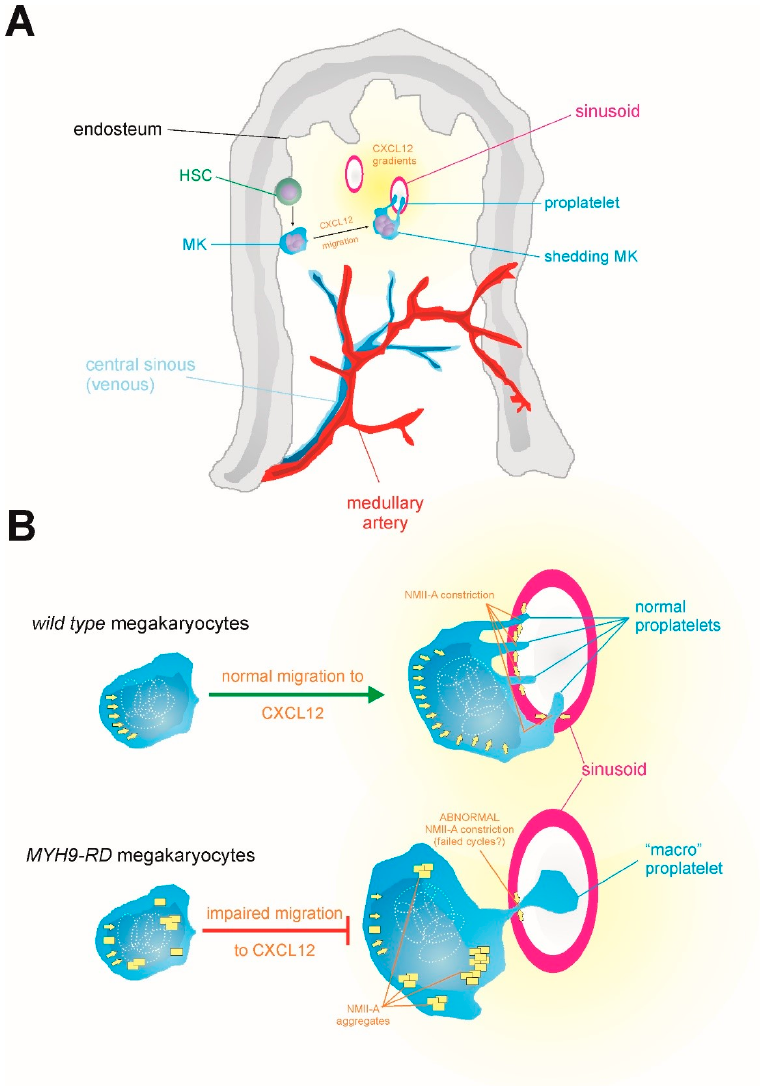
Figure 2. ( A ) Scheme depicting the generation and migration of megakaryocytes (MK) in the bone marrow. MK differentiate from HSC in the endosteum and then migrate towards the sinusoids driven by CXCL12 gradients. There, they insert protrusions in the gaps between endothelial cells lining the sinusoids. The protrusions become proplatelets. ( B ) Comparison between wild-type and MYH9-KD MKs. Ploidy (represented as white dotted ellipses) is normal in both cases, but MYH9-RD MKs migrate deficiently towards sinusoids, which depends on CXCL12 [32]. The combination of the shear stress driven by blood flow in the sinusoid and NMII-A-driven constriction excises the proplatelets (as explained in Section 3). The molecular reason for the onset of macrothrombocytopenia in MYH9RD patients has not been formally explained (see Section 7). The figure also integrates the known role of NMII-A to push the nucleus in three dimensions, represented by yellow arrows behind the multinucleated core. This has not been shown explicitly for MKs, but it has for other cells of hematopoietic origin, such as dendritic cells [33,34]. Yellow squares represent NMII-A aggregates in MYH9-KD MKs. MYH9 -RD patients are differentially diagnosed based on the size of their platelets. However, automated platelet counting does not recognize giant platelets, often leading to misdiagnosis of these syndromes. To distinguish MYH9 -RD from other platelet syndromes, hematologists look for the